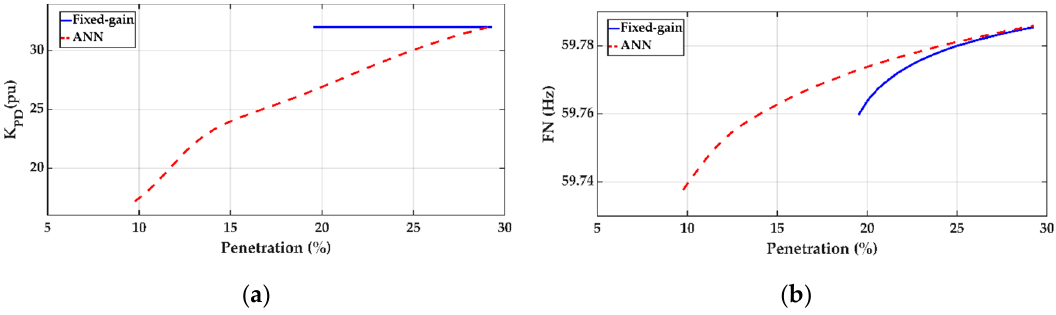
Figure 13. Droop gain K PD and frequency nadir from the ANN-based controller and fixed-gain controller ( ∆ P Load = 30 MW and V W = 11 m/s) under different penetrations. ( a ) Droop gain K PD and ( b ) frequency nadir (FN).